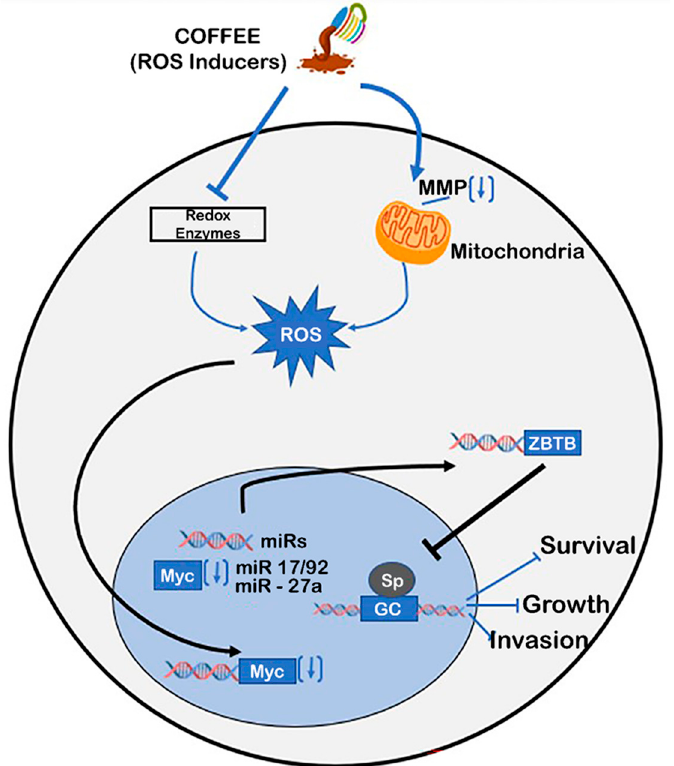
Figure 3. Coffee extracts induce ROS. Treatment of cancer cells with ROS inducers, such as chloro- genic acids and quercetin, inhibits redox enzymes and decreases mitochondrial membrane potential (MMP) to induce ROS, which downregulates cMyc + cMyc-regulated microRNAs (miRs: miR 17- 92/27a). This results in the induction of ZBTB genes (ZBTB4, ZBTB10) + inhibition of pro-oncogenic Sp1/Sp3/Sp4-regulated genes/pathways